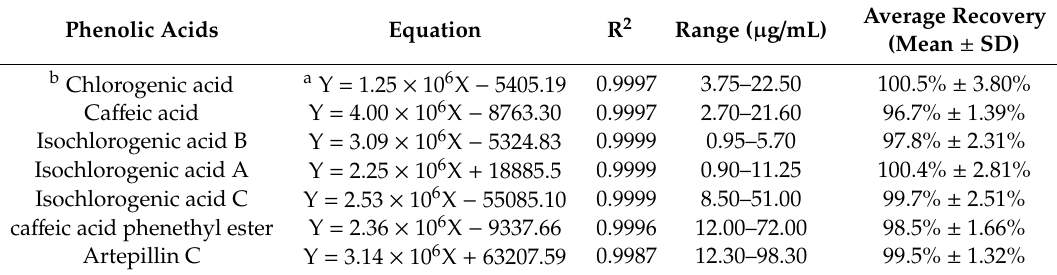
Table 2. Linearity, sensitivity, system precision and accuracy ( n =